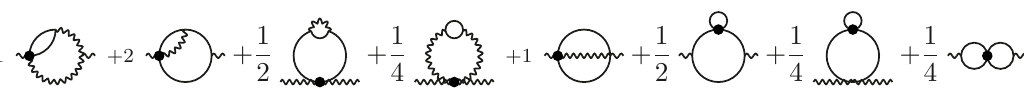
Figure 4 . 2-loop contributions to the 2-point function, originating from 3-point Chapman vertices (the notation is as in figure 3).